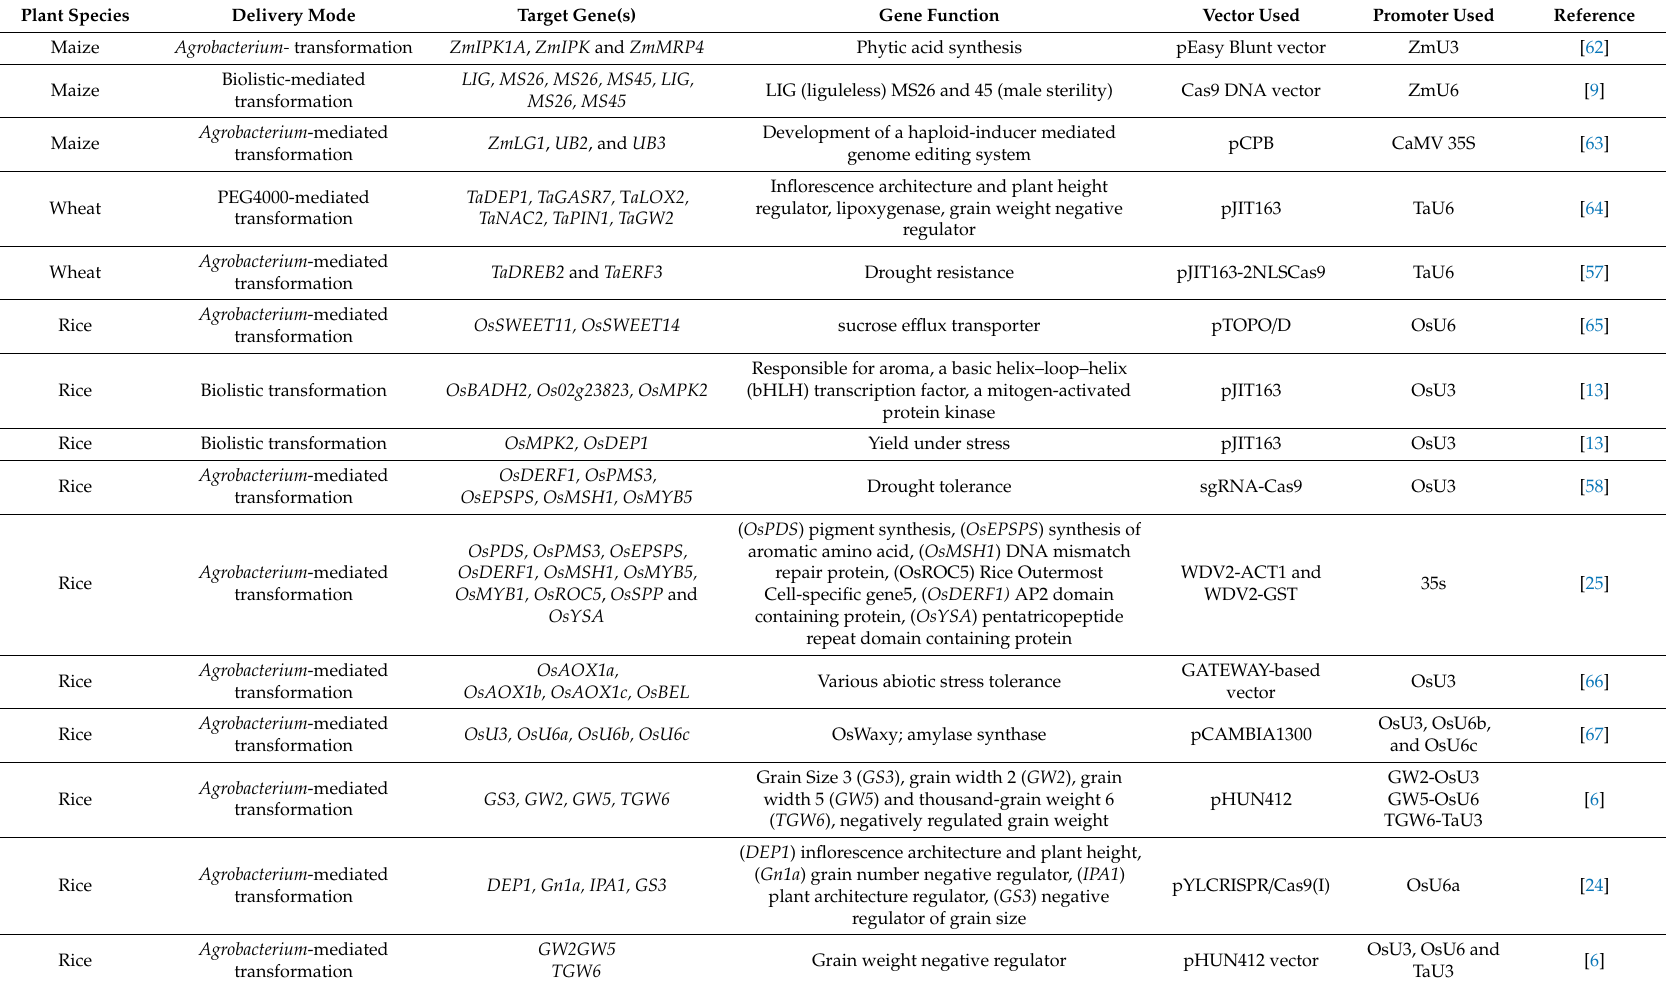
Table 2. List of significant multi target genome-editing studies in cereal